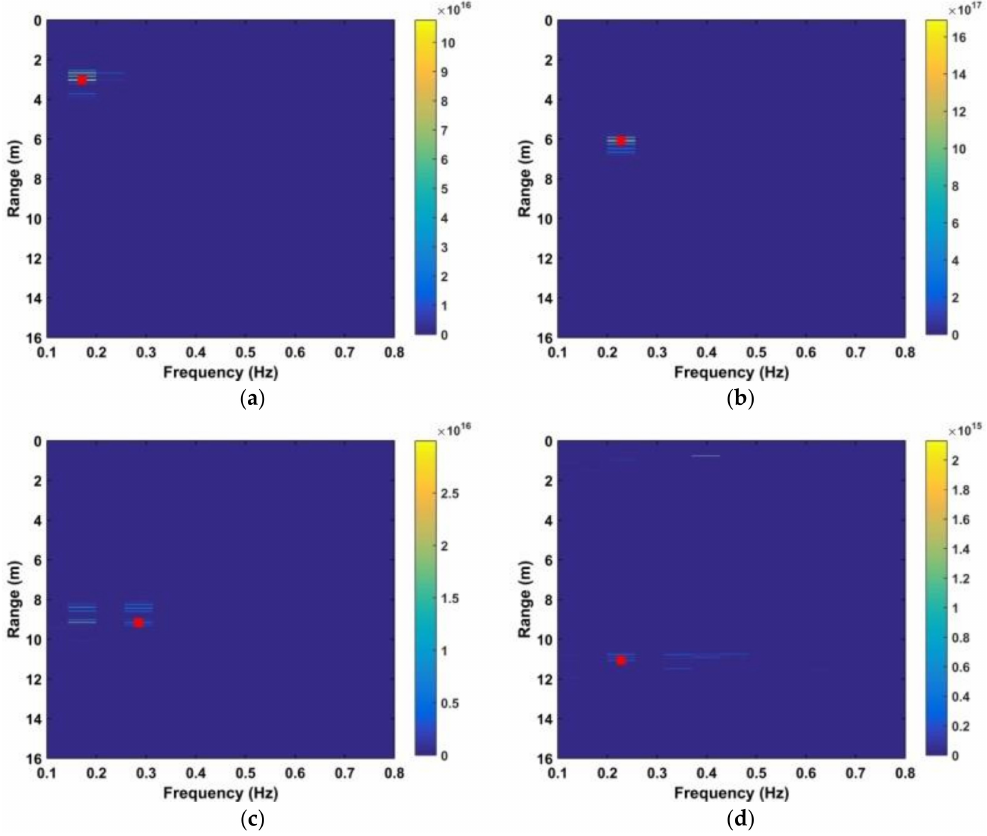
Figure 13. Results after four frequency accumulations at distances between the antenna and human subject of ( a ) 300 cm, ( b ) 600 cm, ( c ) 900 cm, and ( d ) 1100